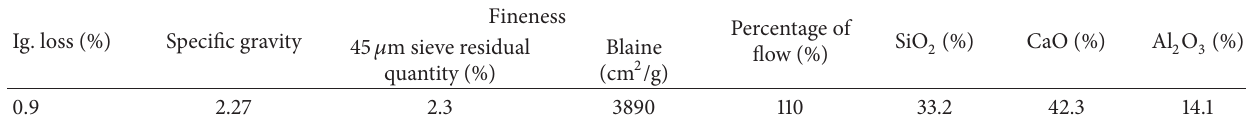
Table 2: Properties of fly ash.